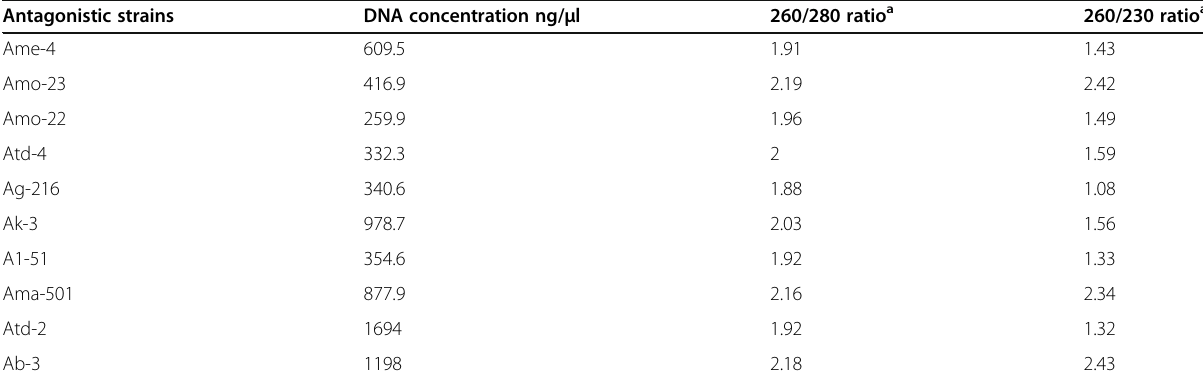
Table 3 Quantification of DNA extracted from the 10 antagonist strains Antagonistic strains